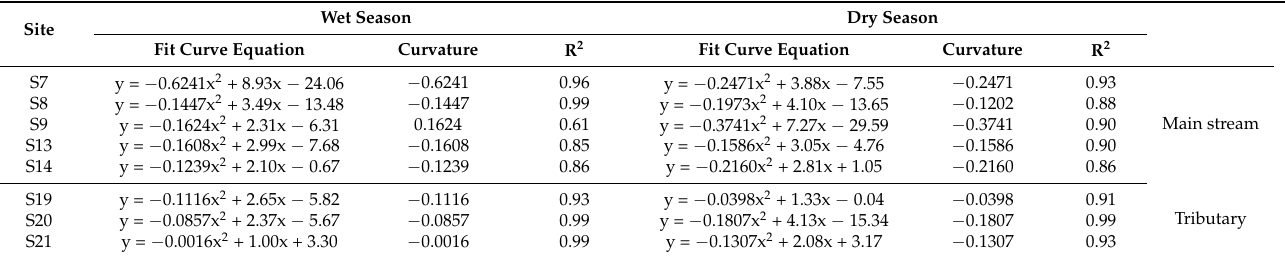
in the upper reaches of the Jinsha